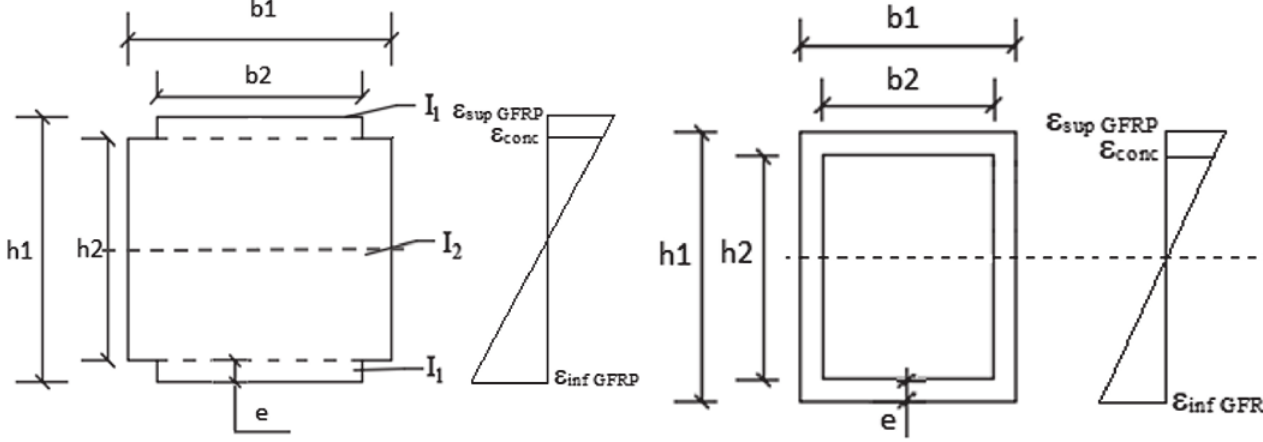
Equivalent homogeneous concrete section